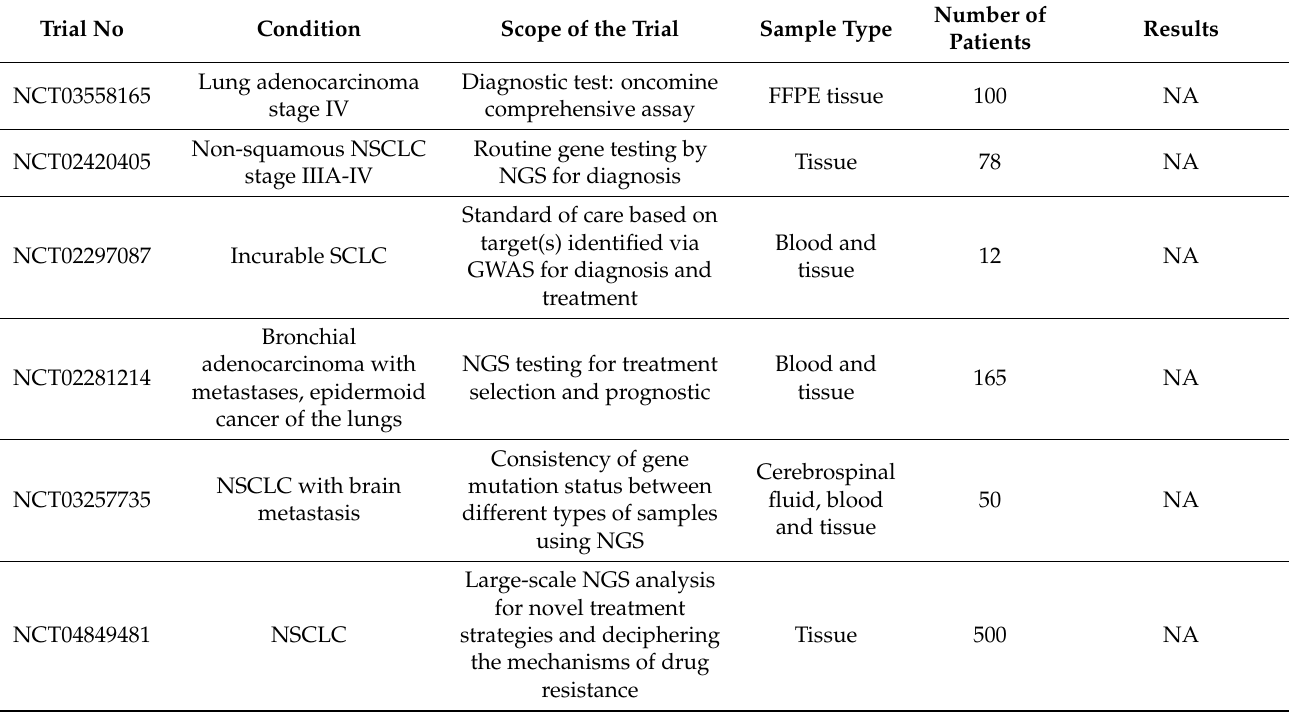
Table 4. Clinical trials on lung cancer diagnosis using NGS